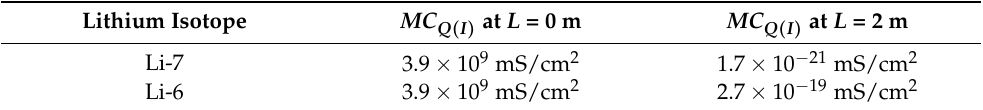
Table 16. The table shows that intracellular lithium isotopes can have a range of quantum membrane conductance from the value at L = 0 m to the value at L = 2 m according to the setting values in graph (b) of Figure 7.